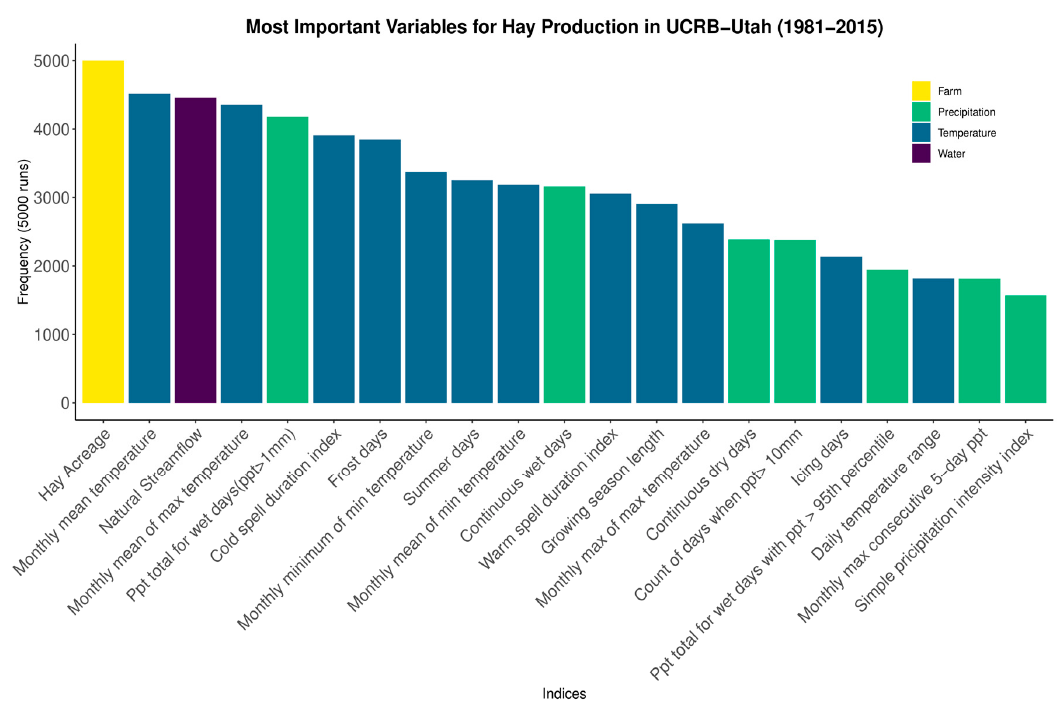
Figure 7. Most important variables for hay production in UCRB-Utah (random forest regression, Figure 8. Most important variables for cattle herd size in UCRB-Utah RFR).